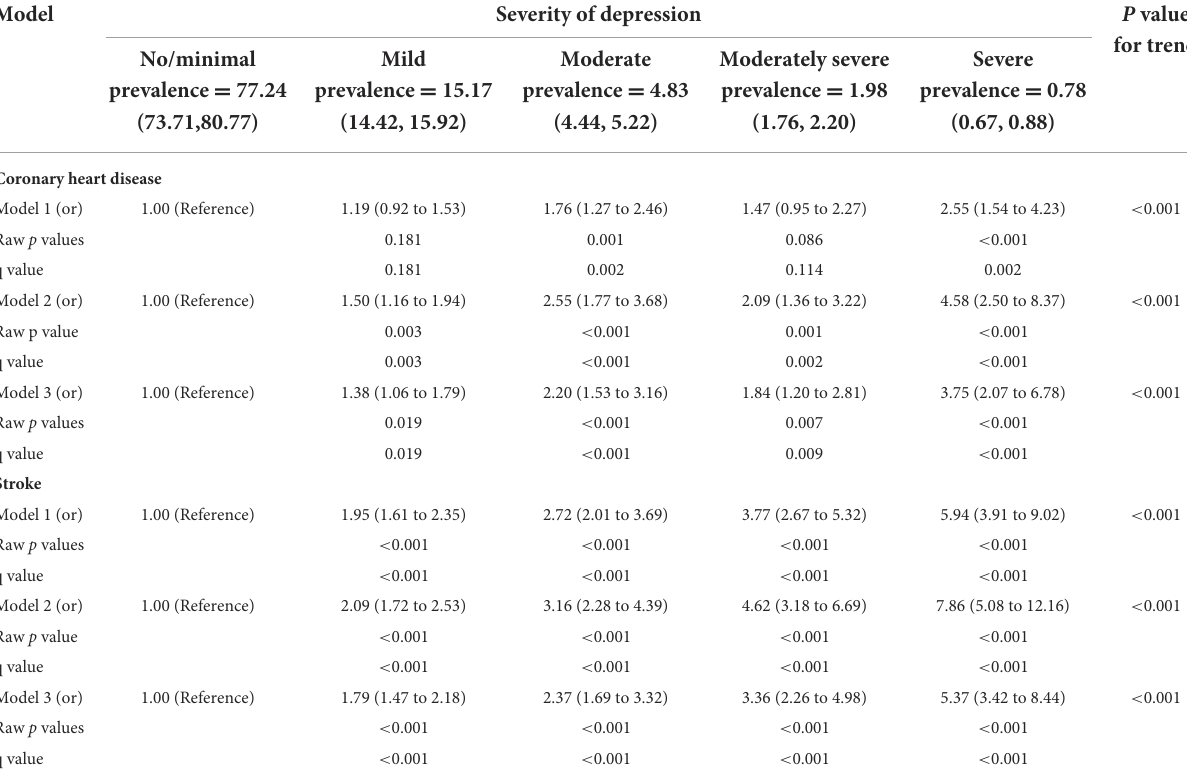
TABLE 2 Crude and adjusted association between depression level and increased coronary heart disease and stroke